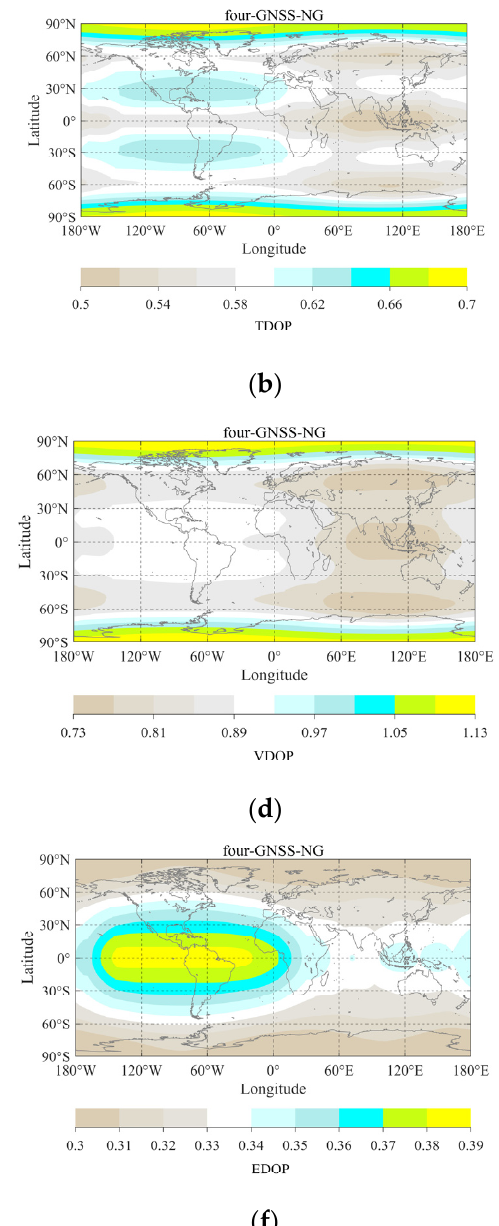
11 of 22 Figure 6. Satellite visibility and GDOP of four-GNSS: ( a ) visible satellites of four-GNSS; ( b ) visible satellites of four-GNSS- NG; ( c ) GDOP of four-GNSS; ( d ) GDOP of four-GNSS-NG. Based on Equation (15), we calculated the DOPs of combined positioning of the four- GNSS-NG. The results are presented in Figure 7. From Figure 7a,b, we found that the distributions of PDOP and TDOP are similar to the GDOP. The average PDOP and TDOP are 1.03 and 0.60, respectively. As shown in Figure 7c,d, the HDOP is from 0.42 to 0.56 (average: 0.49), and the VDOP is between 0.73 and 1.13 (average: 0.90). Both of these val- ues are lower in the Asia-Pacific region. However, the HDOP is larger at latitudes of  6030 ≤≤ B